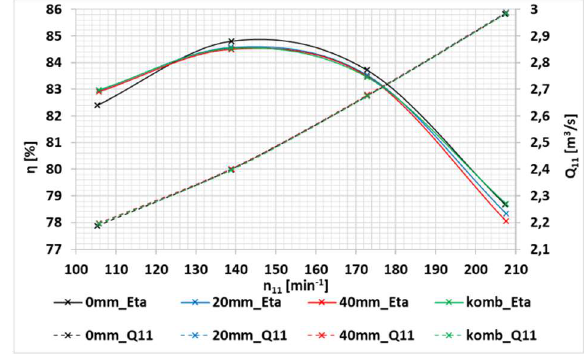
Fig. 8 Comparison of n 11 - Q 11 characteristics for all configurations The n 11 - Q 11 characteristics show, that a small blade displacement (compared to the runner dimensions) has no major impact on the flow characteristics. A light drop of hydraulic efficiency is significant, but it does not exceed more than one percent. The performance characteristics of all configurations correspond to the original one with maximum difference of 0.5 % (Fig. 9).